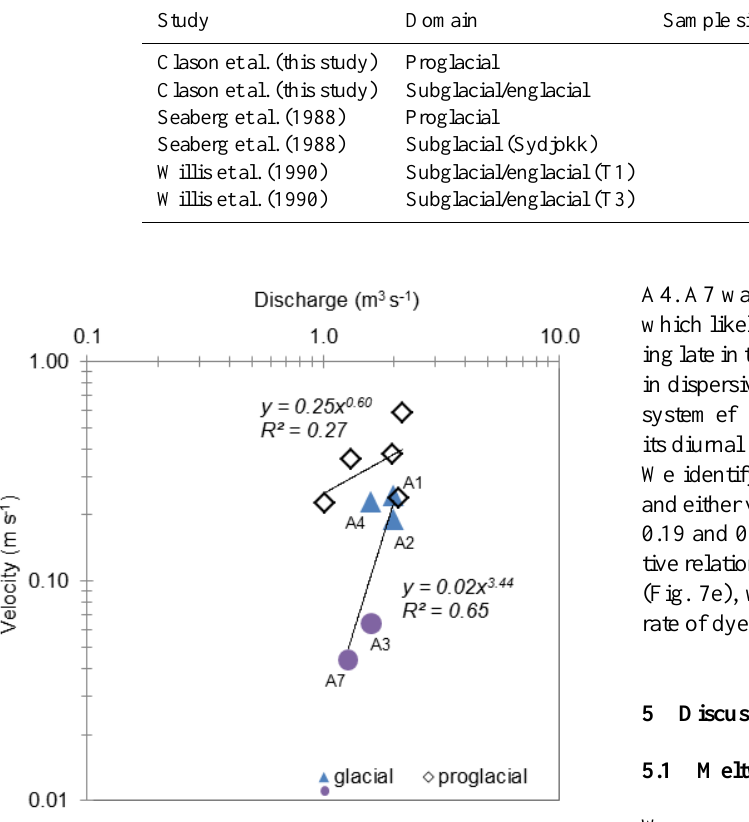
Figure 6. Velocity plotted against discharge for proglacial and glacier-based dye tracer tests conducted during August 2013. Note that the July experiments are not included because there are no con- temporaneous measurements of stage from which to calculate dis- charge. Flow regimes 3 and 4 are illustrated by blue triangles and purple circles